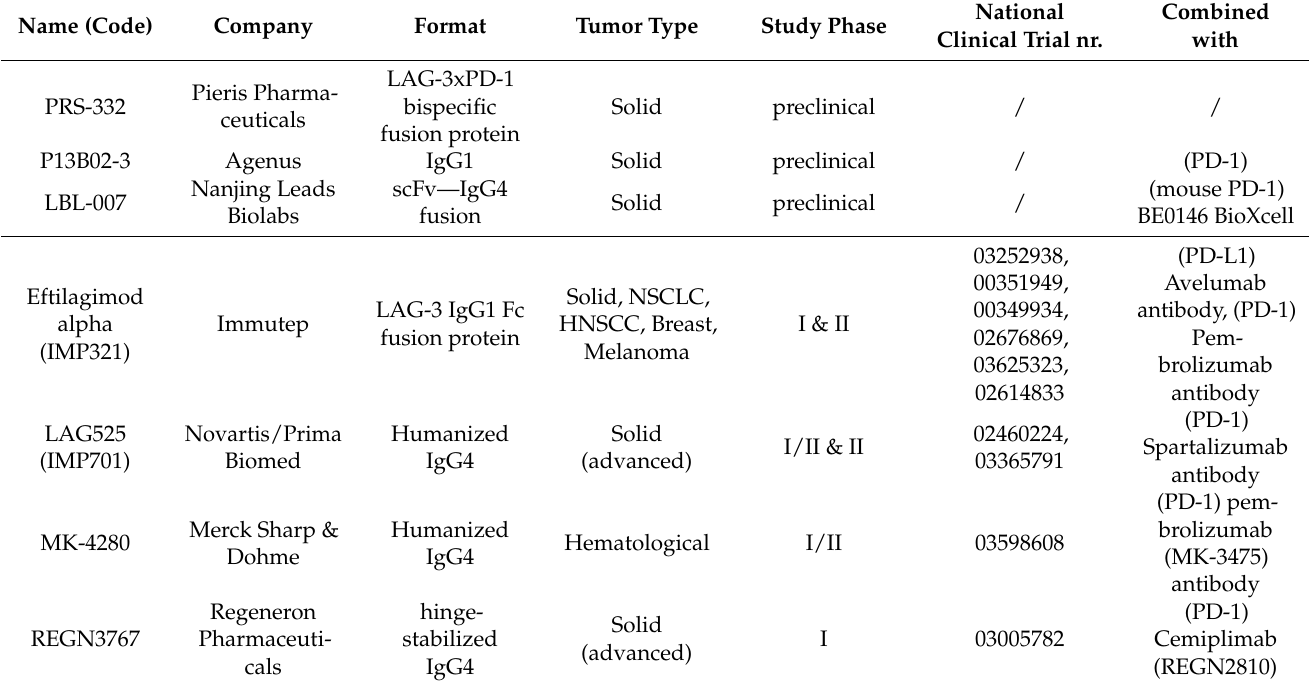
Table 1. Table summarizing the 15 compounds under development for blockade of